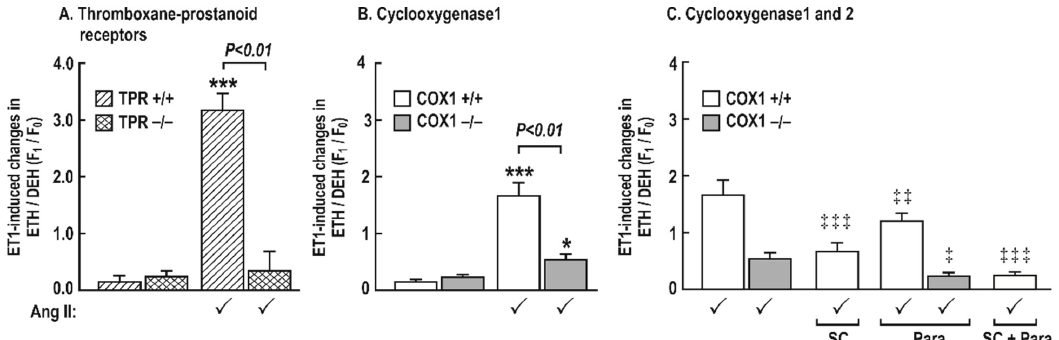
Figure 7. The changes in the generation of reactive oxygen species after a 5 min incubation with endothelin 1 (10 − 7 mol · L − 1 ) in mesenteric resistance arterioles from mice with angiotensin II infusion at 400 ng · kg − 1 · min − 1 sc × 14 days is reduced in vessels from cyclooxygenase 1 − / − mice or by blockade of cyclooxygenase (COX) 1 ( B ) or 2 ( C ) and is prevented in vessels from thromboxane prostanoid receptor (TPR) − / − mice or by combined blockade of COX1 and 2 ( A ). Mean ± SEM values ( n = 8 per group) for ROS generation (ethidium (ETH)—dihydroethidium (DEH) fluorescence ratio) was increased in the in response to endothelin 1 (10 − 7 mol · L − 1 ) in vessels incubated for 5 min with a vehicle, SC-560 (SC; 10 − 6 mol · L − 1 ), and / or paracoxib (Para; 10 − 5 mol · L − 1 ). E ff ect of angiotensin II infusion: * P <